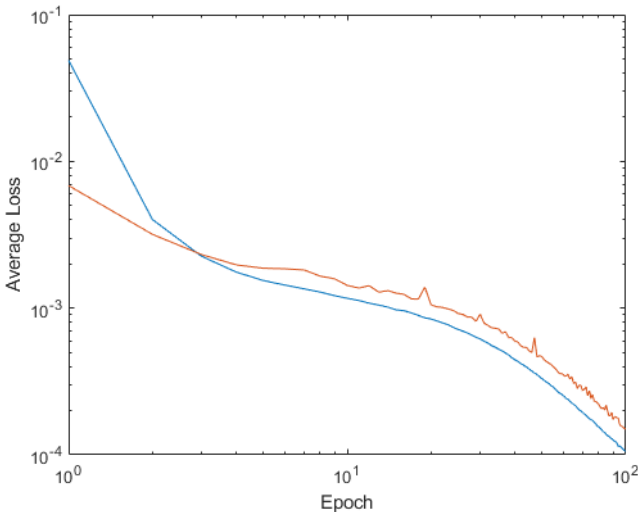
Figure 1. Average loss on training patterns in blue and validation patterns in orange for the standard SGD learning of Mexican Hat.